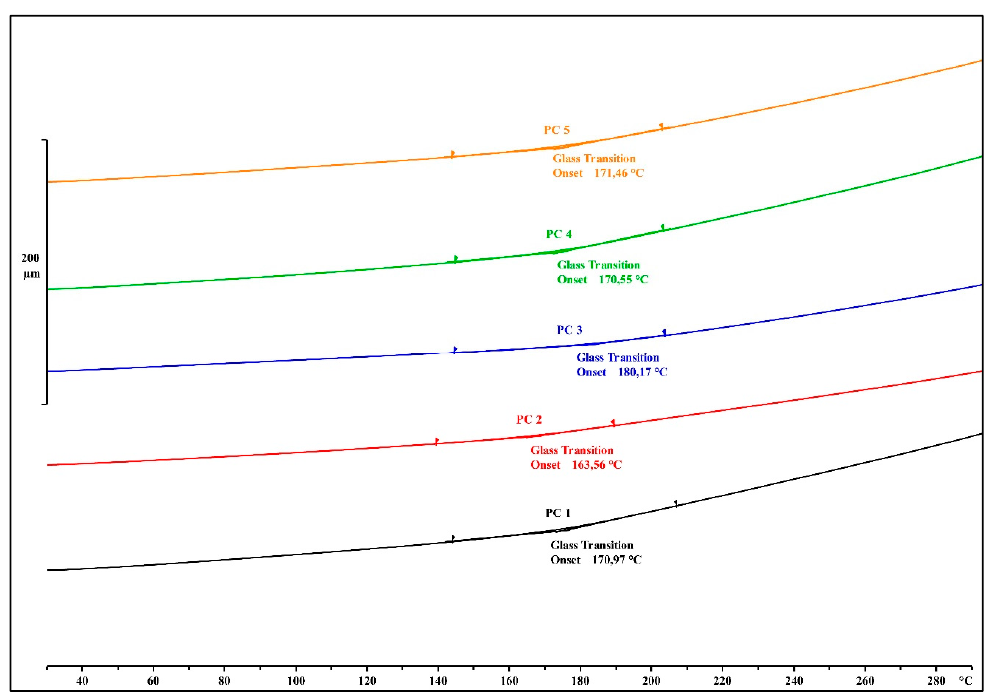
Figure 6. Glass transition temperature (T g ) determination of the EMC samples.